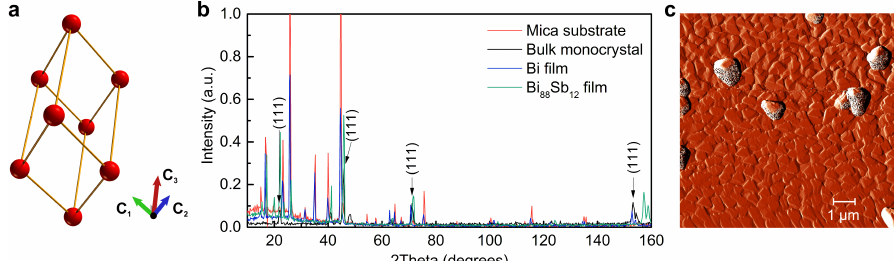
Figure 1. ( a ) Bismuth-like crystal structure. ( b ) X-ray diffraction patterns (Cu K- α emitter) for mica substrate, bulk Bi(111) monocrystal and a thin Bi and Bi 88 Sb 12 films on substrate. ( c ) AFM image of a 150 nm film surface crystal (growth figures of a triangular shape and the observed (111) plane of the hexagonal